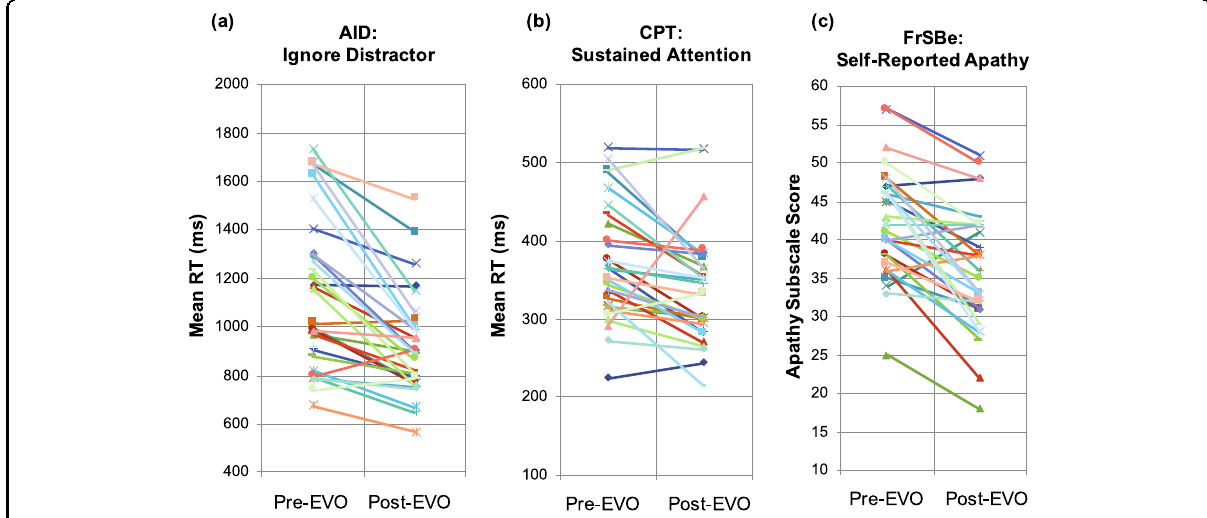
Fig. 2 Improvement in cognitive control performance and self-reported cognitive control symptoms following 4 weeks of the EVO intervention. a Change in mean response time (RT) from pre- to post-EVO on the Ignore Distractor condition of the AID task, a measure of working memory. (Pre-EVO: M = 1141.50 ms (321.23); post-EVO: M = 920.98 ms (214.39); pre vs. Post: t(29) = 5.92, p < 0.001). b Change in mean RT from pre- to post-EVO on the Sustained Attention condition of the CPT. (Pre-EVO: M = 1069.38 ms (261.25); Post-EVO: M = 886.67 ms (204.19); pre vs. Post: t(29) = 5.00, p < 0.001). c Change in score from pre- to post-EVO on the Apathy Subscale score of the FrSBe self-report scale. (Pre-EVO: M = 42.30 (7.13); Post- EVO: M = 36.03 (8.01); pre vs. post: t(29) = 5.82, p <